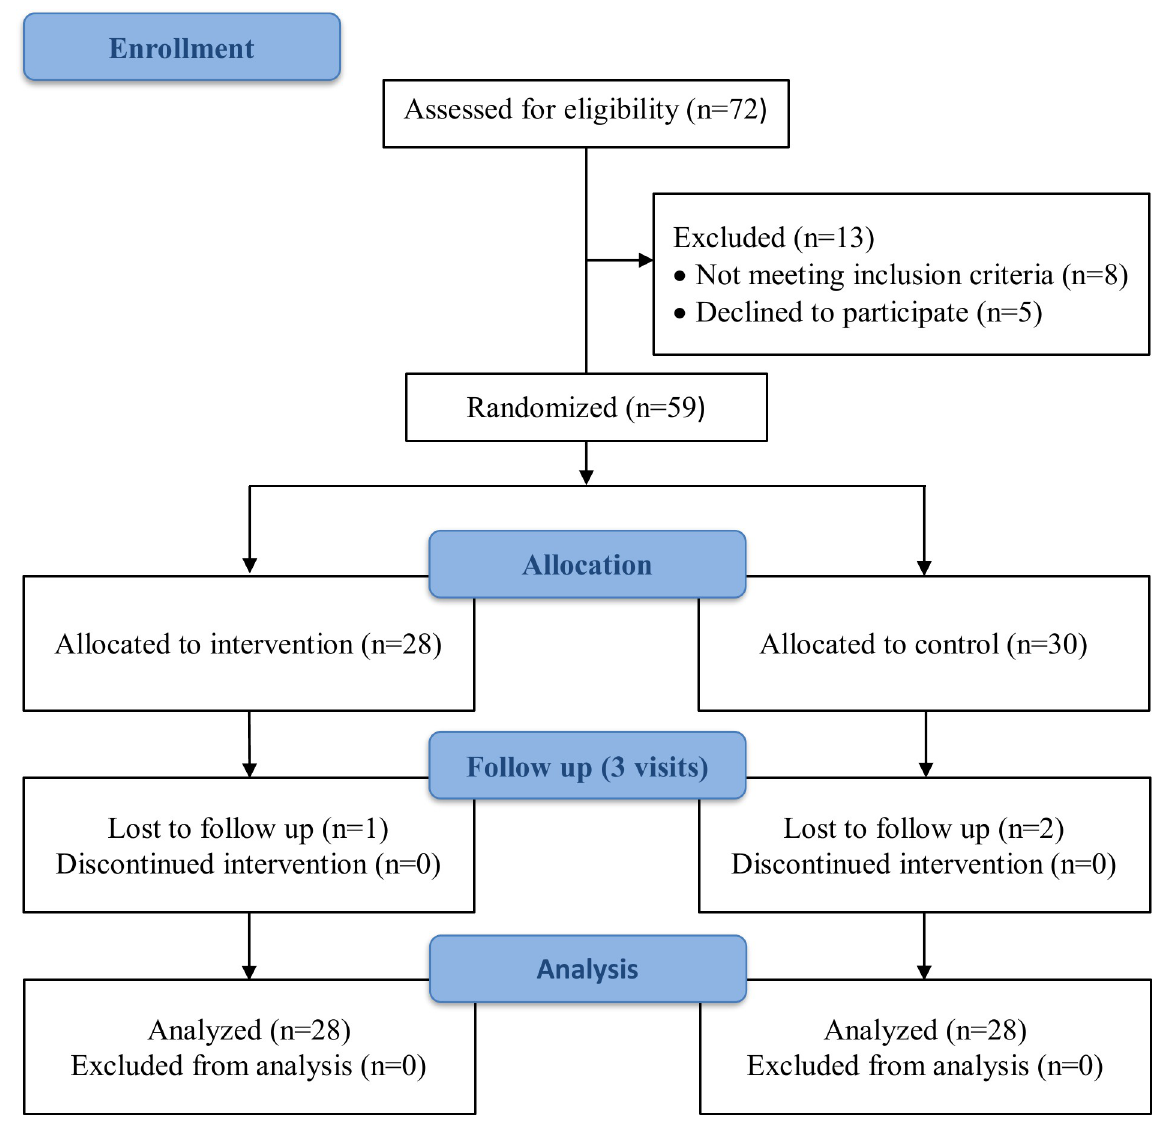
Fig 1. CONSORT flow diagram.